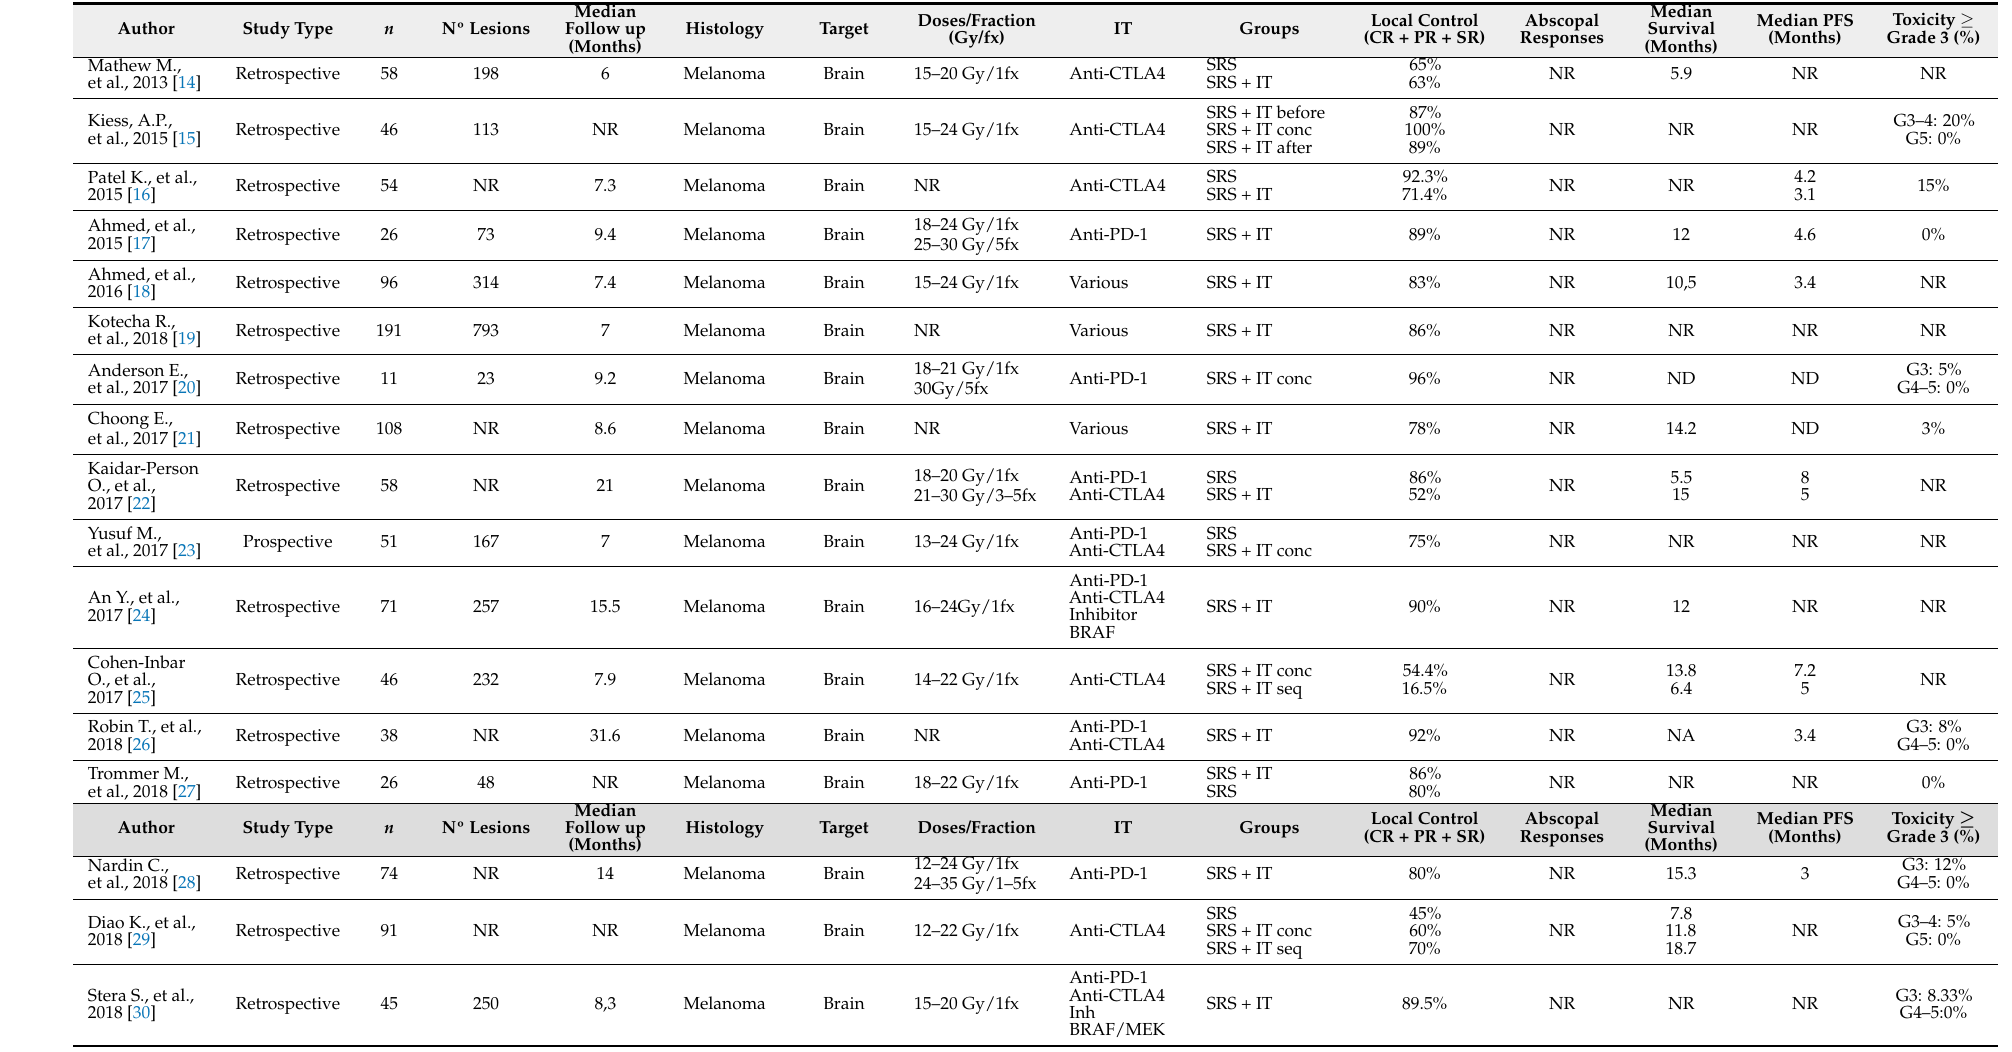
Table 1. Results of the ICI + SRS combination in cerebral metastases in melanoma/non-small-cell lung cancer ( n =